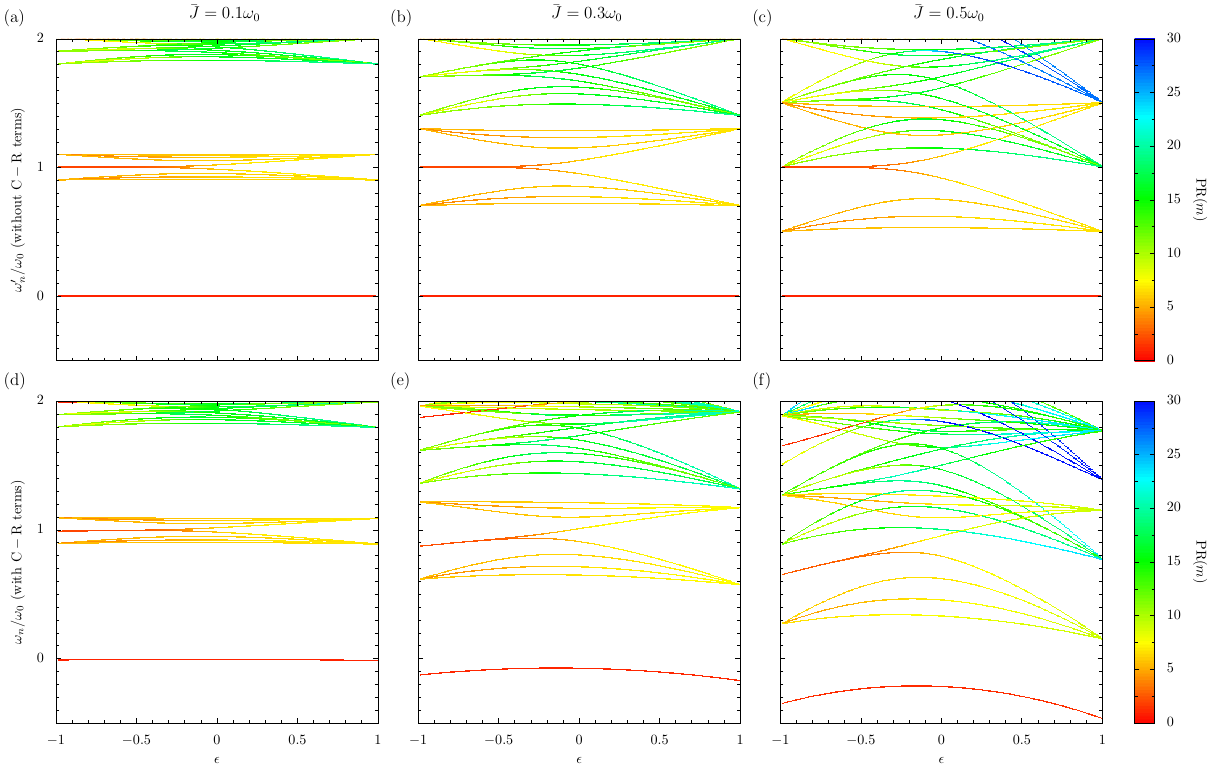
Figure 5. Topology in the ultrastrong coupling regime. Eigenfrequencies as a function of the dimerization parameter ǫ , with increasing coupling strength ¯ J in each column [cf. Eq. (7)]. Colour bars: the participation ratio PR ( n ) of each eigenstate. Panels ( a – c ): the results without taking counter-rotating terms in the Hamiltonian of Eq. (6) into account, namely the RWA eigenfrequencies ω ′ n and RWA eigenstates ψ n eigenfrequencies ω n and eigenstates are used. In the figure, the chain is of size N || �� 2 8 256 dimensional Hilbert space) and all data above 2 ω 0 is =